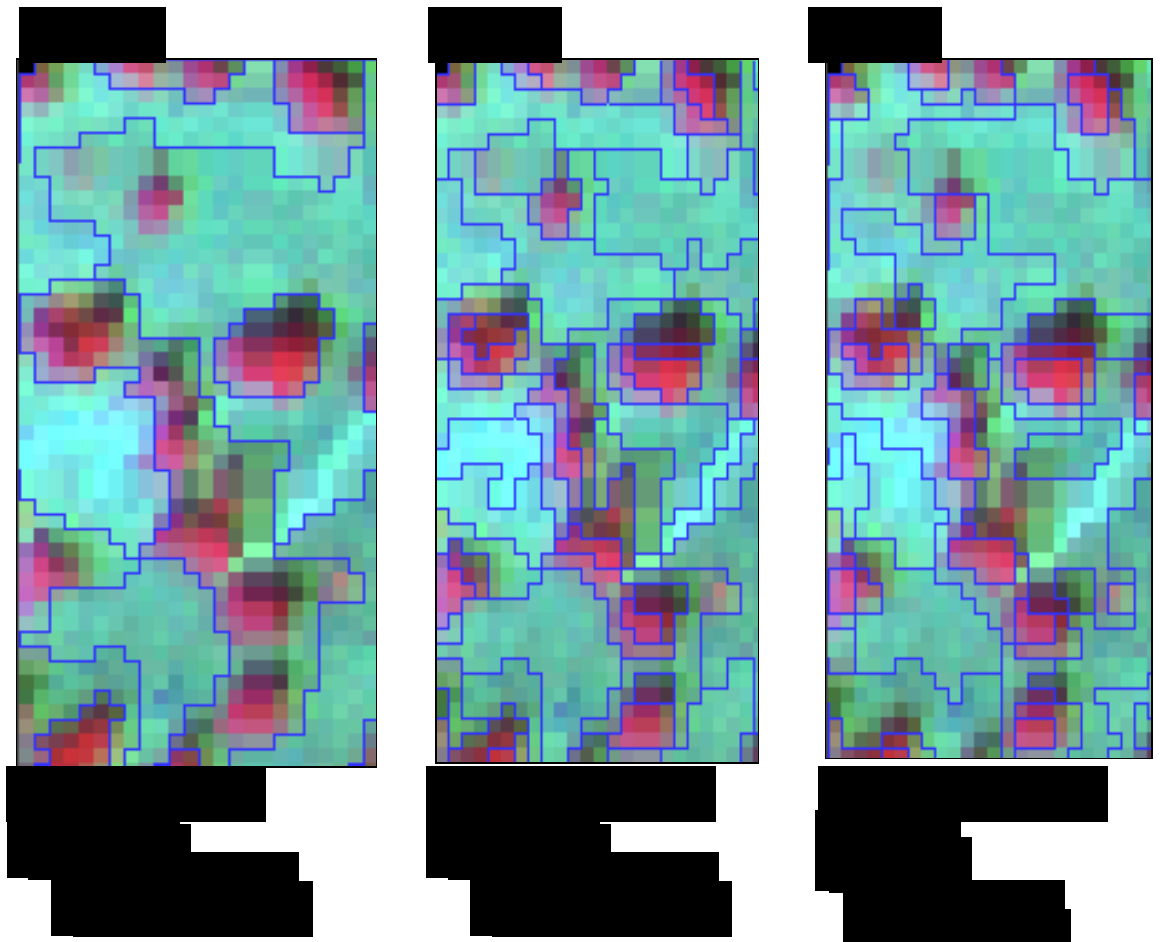
Figure 3. Scale, color, shape, smoothness and compactness parameters used for selecting the most optimal segmentation. A scale parameter of 30 generates smallest segments of about 5 m in width and can capture large crowns and sub-stand characteristics, in comparison a scale parameter of 9 generates smallest segments of about 1m in width and can segments trees to sub components such as crowns and shadows. The higher the scale parameter the more general the segments are, thus, in this resolution imagery a scale parameter of 100 captures general stand types and a scale parameter of 200 can capture general landscape